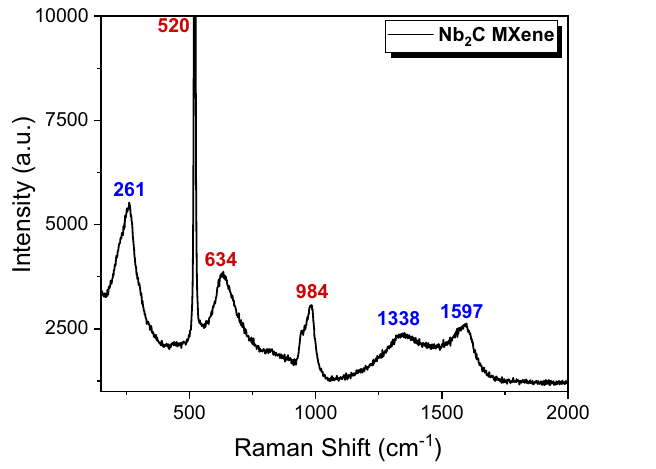
Figure 2. Raman spectrum of Nb 2 C